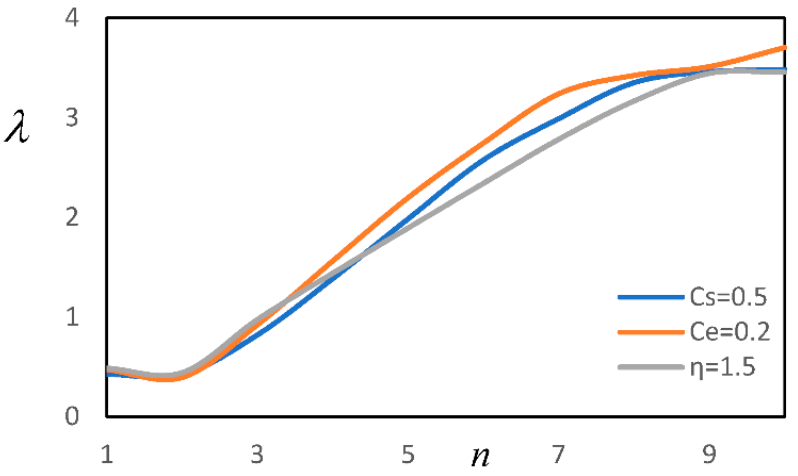
Figure 3. The relation of fundamental frequency parameter and circumferential node number of two-layered annular circular plates with ply orientation 30 0 / − 30 0 ( KGE / KGE ) . β = 0.5 and γ = 0.05. Figure 4 narrates the angular frequency parameter ω with respect to radii ratio β and